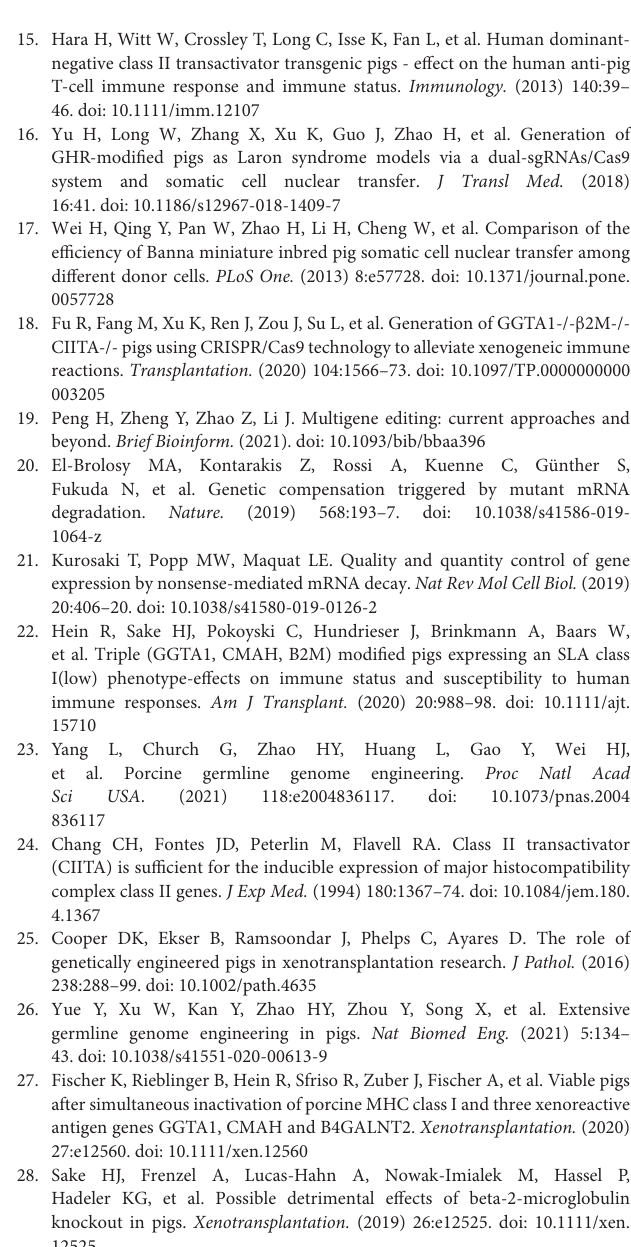
Supplementary Figure 1 | Verification of RNA-seq data quality. (A) The Pearson correlation coefficient between GBC-modified and WT pigs. (B) Boxplots of the gene expression distributions. Supplementary Figure 2 | Expression levels of GGTA1, B2M, and CIITA genes analyzed by RNA-seq in the PBMCs of the pig’s spleen. Supplementary Table 1 | Sample information. Supplementary Table 2 | The primers of